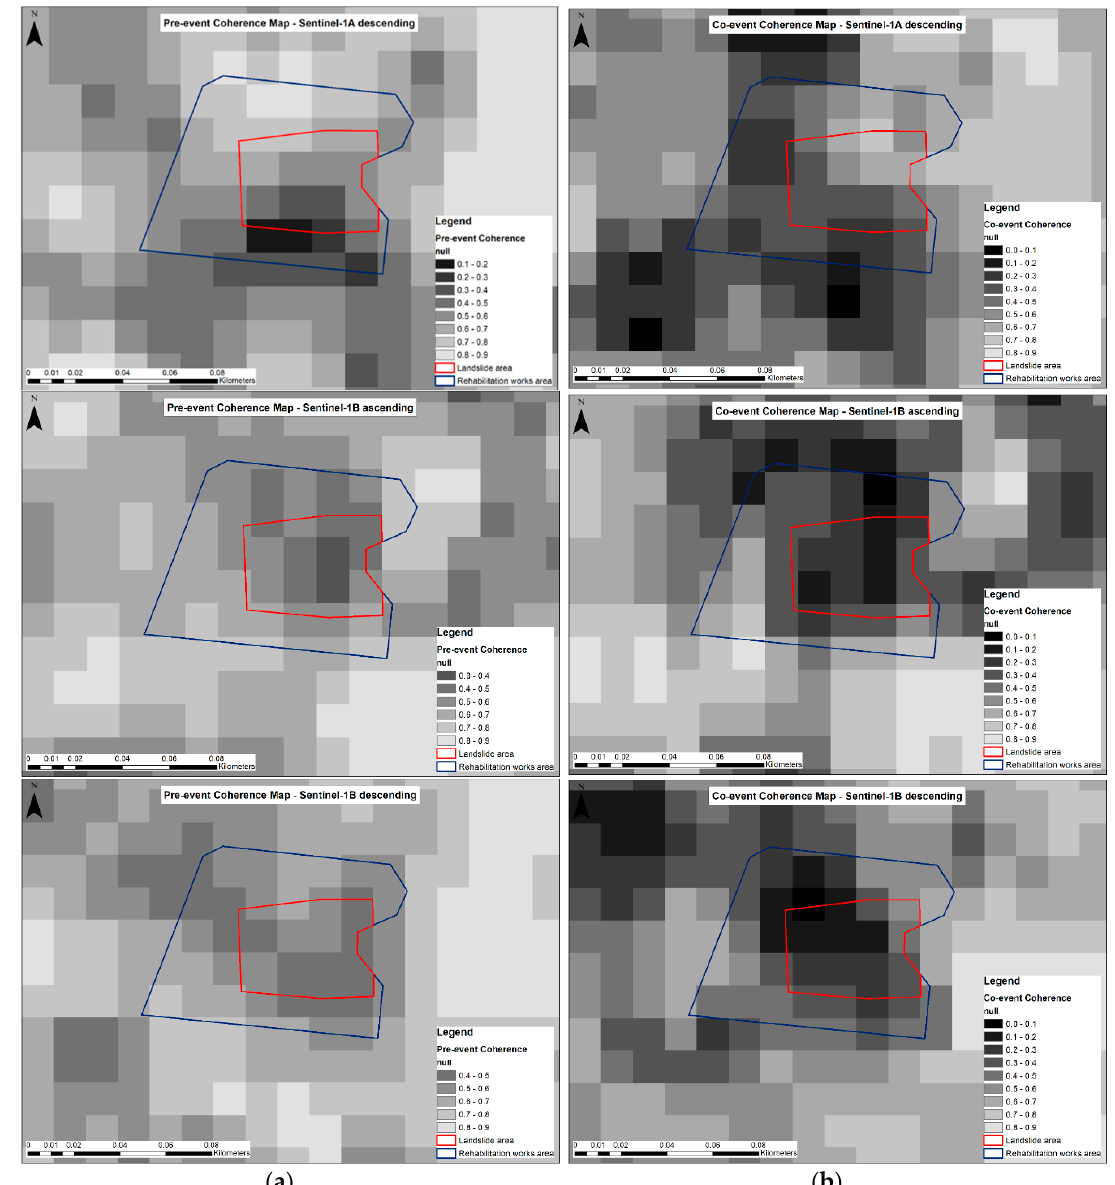
Figure 15. ( a ) Pre-event and ( b ) co-event coherence maps – Sentinel-1A ascending (first), Sentinel-1A descending (second), Sentinel 1-B ascending (third), and Sentinel-1B descending (fourth).